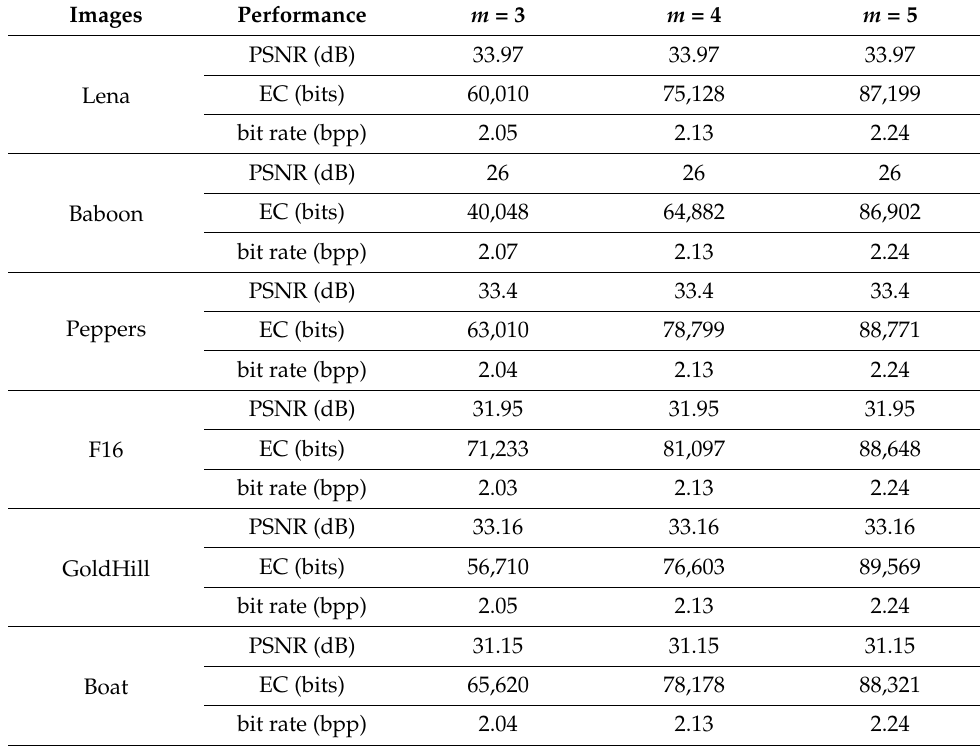
Table 1. Performance of the proposed scheme under difference values of m.